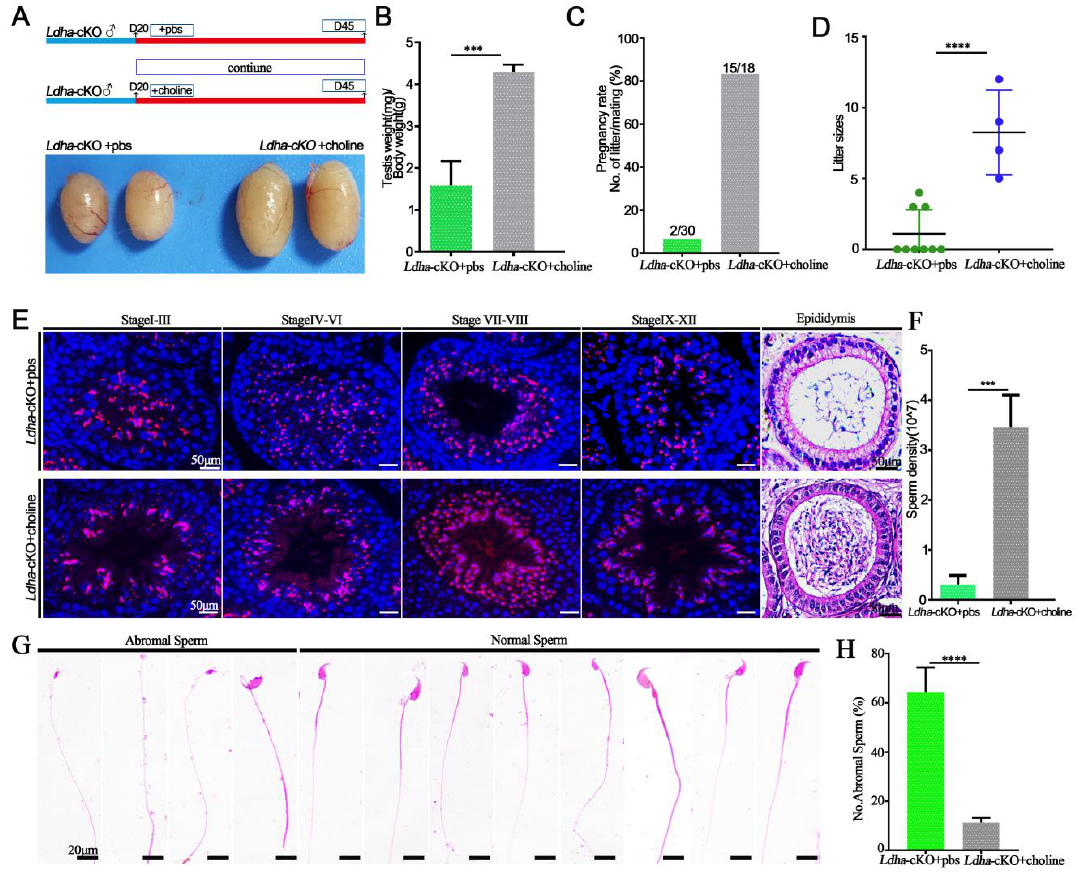
Figure 6. Choline can rescue the phenotype of Ldha -cKO mice. ( A ) Flowchart of the rescue experiment sets. ( B ) Ratios of testes-to-bodyweight of the Ldha -cKO mice treated with PBS as a control (n = 3) and Ldha -cKO (n = 5) mice treated with choline at three monthsold. *** indicates a significant difference of p < 0.001. ( C ) Pregnancy rate was calculated as the ratio of the number of females pregnant to the number of females with successful mating from the Ldha -cKO mice treated with PBS as a control (n = 3) and Ldha -cKO (n = 5) mice treated with choline. ( D ) Comparisons of litter sizes from the Ldha -cKO mice treated with PBS as a control (n = 3) and Ldha -cKO (n = 5) mice treated with choline at three monthsold. **** indicates a significant difference of p < 0.0001. ( E ) Representative images of PNA of testes and H&E staining of cauda epididymis from the Ldha -cKO mice with added PBS as a control (n = 3) and Ldha -cKO (n = 5) mice with added choline at three months old (scale bars = 50 µ m). ( F ) Comparisons of sperm concentration from the Ldha -cKO mice treated with PBS as a control (n = 3) and Ldha -cKO (n = 5) mice treated with choline for 25 days. *** indicates a significant difference of p < 0.001. ( G ) Image of abnormal and normal sperm. (Scale bar = 20 µ m). ( H ) Comparisons of abnormal sperm from the Ldha -cKO mice treated with PBS as a control (n = 3) and Ldha -cKO (n = 5) mice treated with choline. In a mouse, 200 sperm were counted and used to calculate the total percentage of abnormal sperm morphology. **** indicates a significant difference of p <